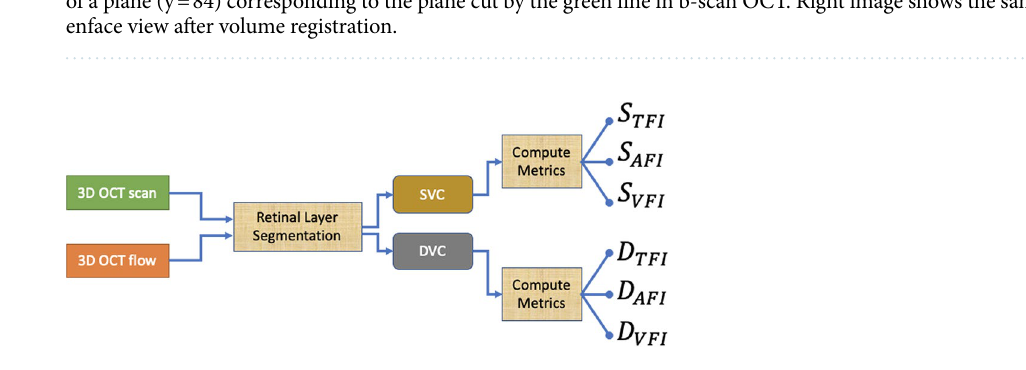
Figure 6. Workflow for computing TFI, AFI and VFI OCTA metrics. OCT optical coherence tomography, OCTA optical coherence tomography angiography, SVC superficial vascular complex, DVC deep vascular complex, TFI total flow intensity. AFI active flow intensity, VFI volume-related flow